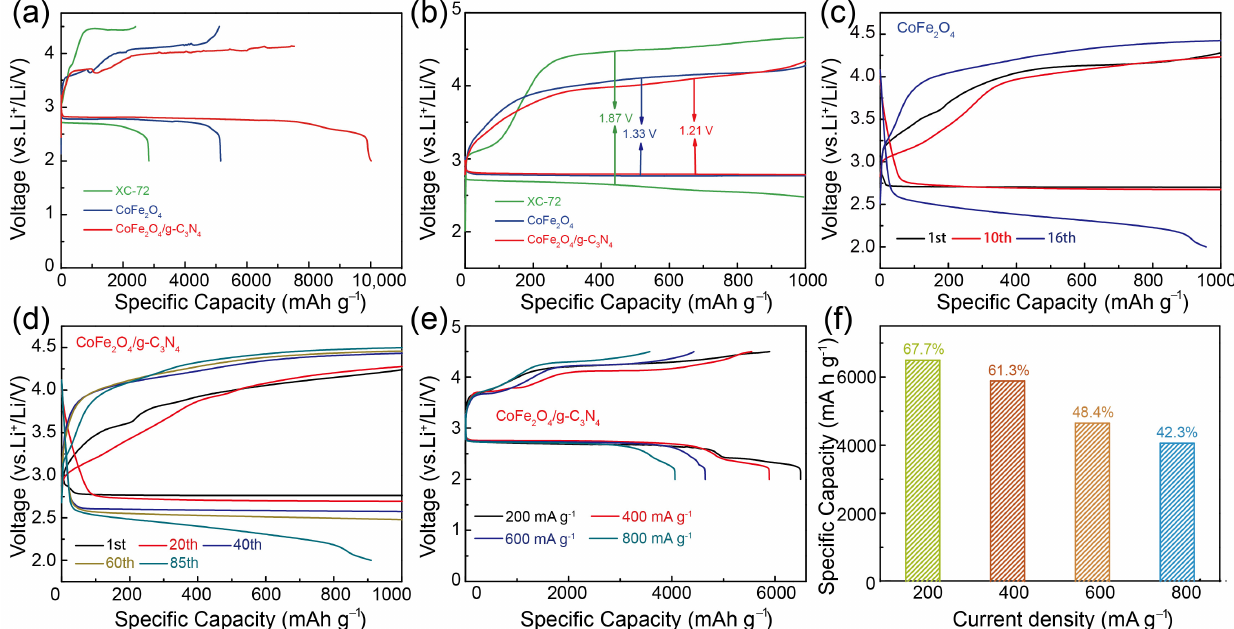
Figure 4. ( a ) First discharge–charge curves and ( b ) the overpotential curves of XC-72, CoFe 2 O 4 , and CoFe 2 O 4 /g-C 3 N 4 ; cycle ability of ( c ) CoFe 2 O 4 and ( d ) CoFe 2 O 4 /g-C 3 N 4 ; ( e ) first discharge–charge plots at different current densities (200, 400, 600, and 800 mA g − 1 ) and ( f ) capacity retention plots of CoFe 2 O 4 /g-C 3 N 4